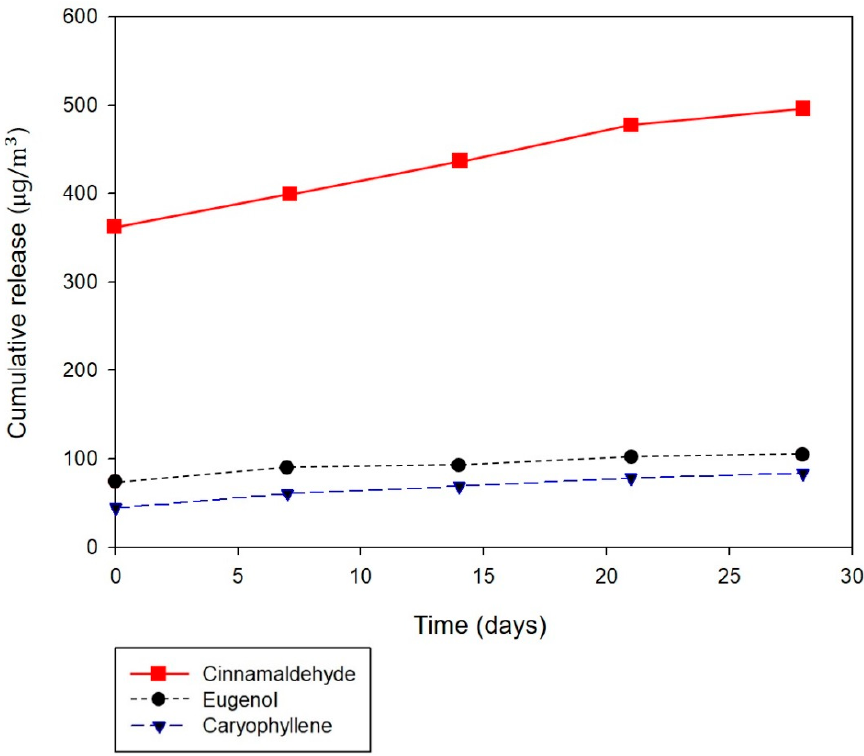
Figure 9. Cumulative release of the major chemical components of cinnamon oil (cinnamaldehyde, eugenol, and caryophyllene) from nanofibrous membranes containing cinnamon oil.